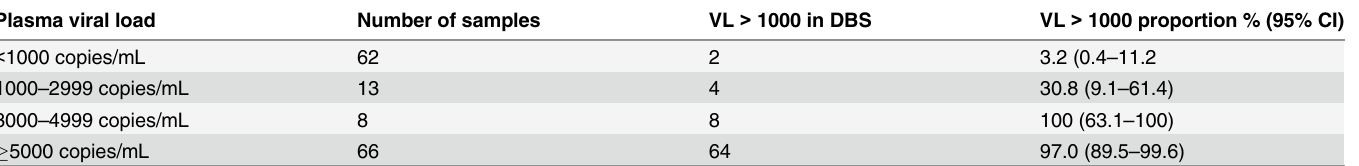
Table 1. Plasma viral load and corresponding HIV RNA detection rates in dried blood spots.